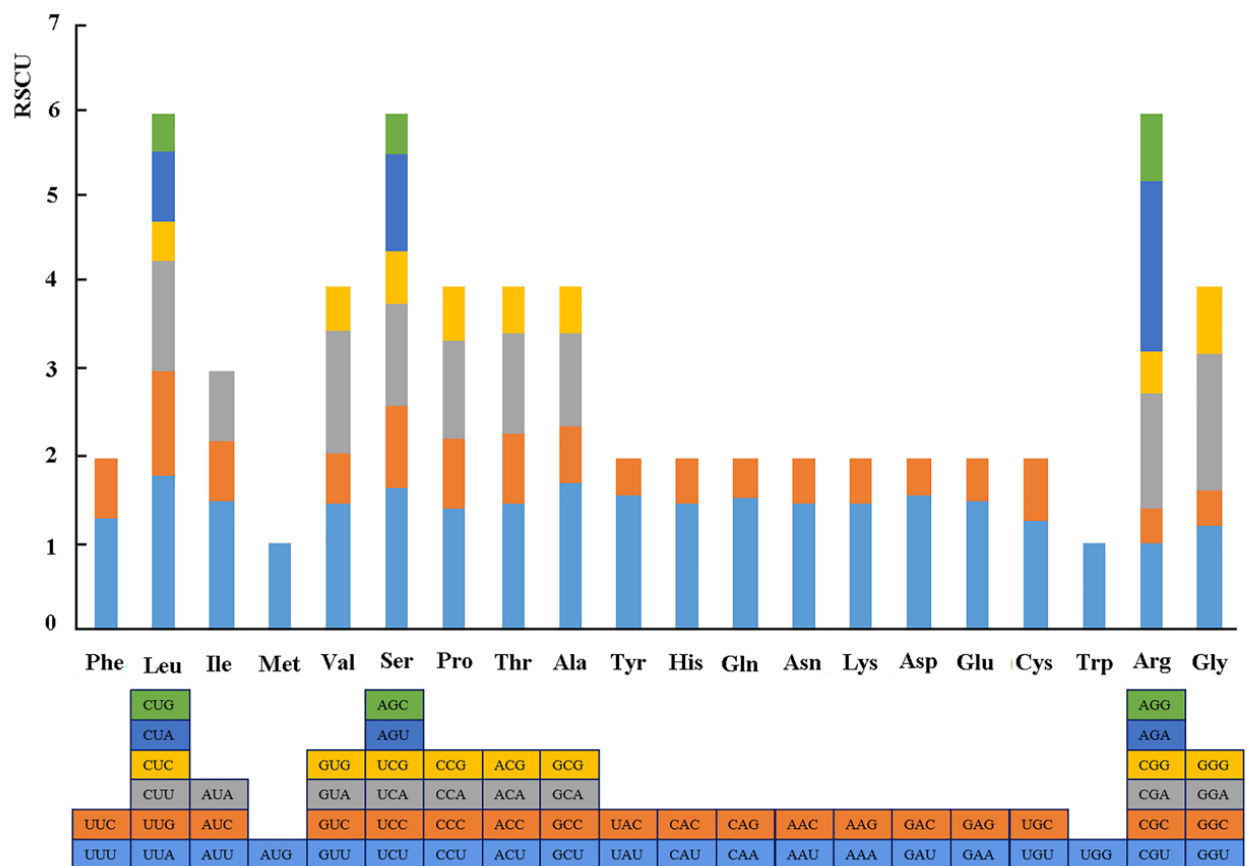
Figure 2. Relative synonymous codon usage (RSCU) of the complete chloroplast genome of R. chinensis in this study.